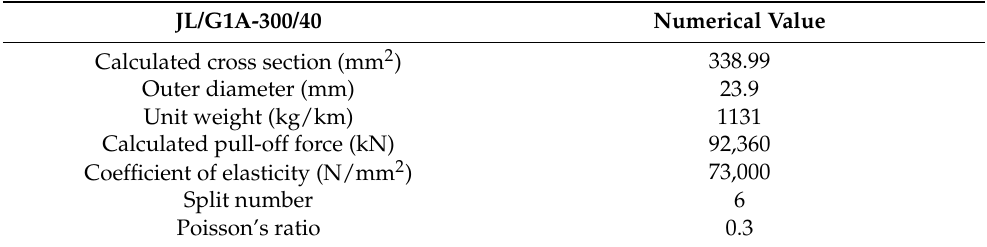
Figure 5. Sectional diagram of the transmission line.